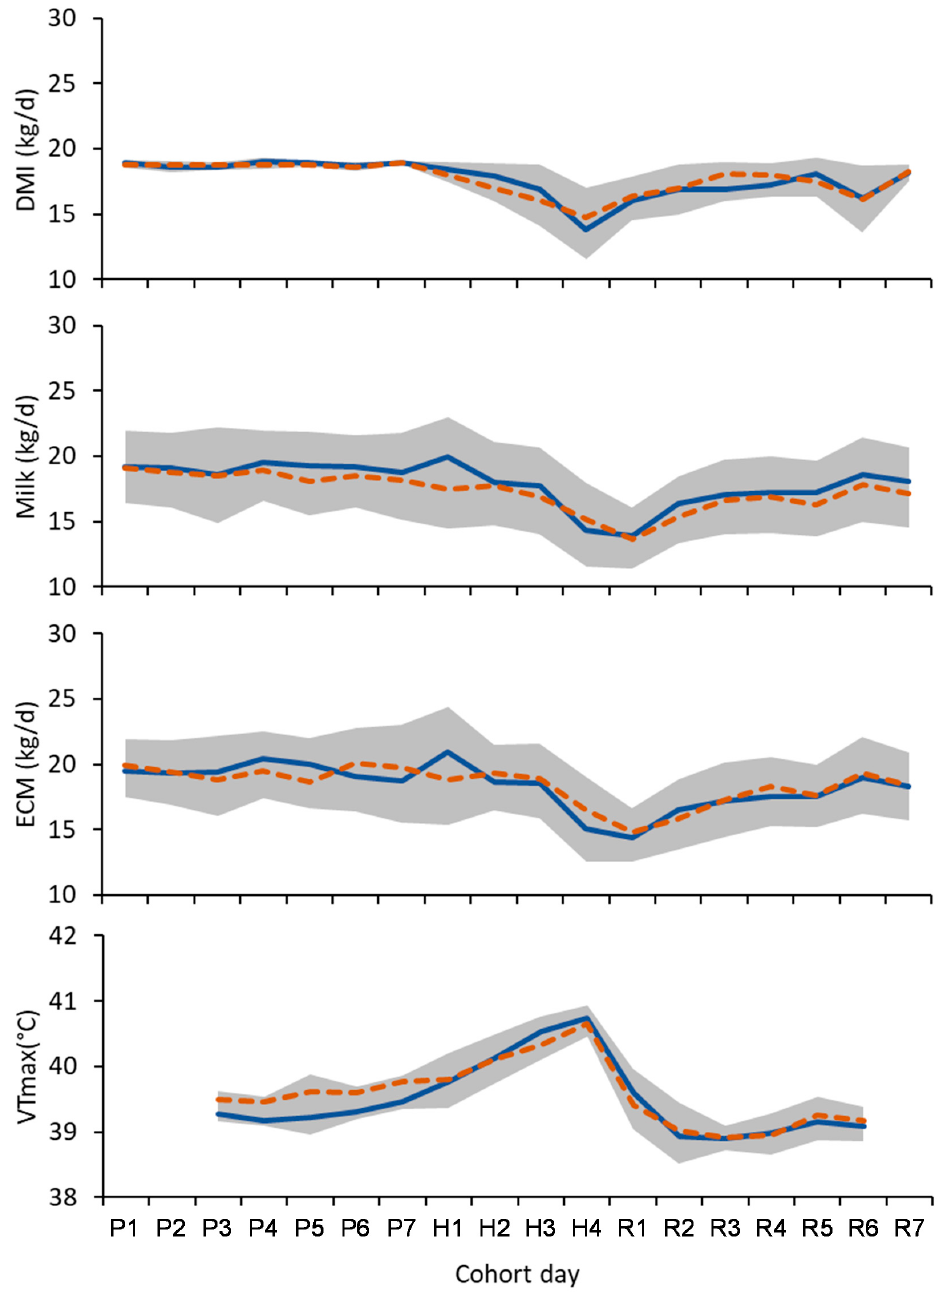
Figure 2. Mean daily dry matter intake (DMI), milk yield, energy-corrected milk yield (ECM) and maximum vaginal temperature (VTmax) of cows offered corn grain (solid blue line) or wheat grain (dashed brown line) before (P), during (H), and after (R) a heat challenge. The shaded grey band shows ± one standard deviation about the experiment mean. The heat challenge was generated in controlled-climate chambers, and cows were kept in ambient conditions before and after the heat challenge.